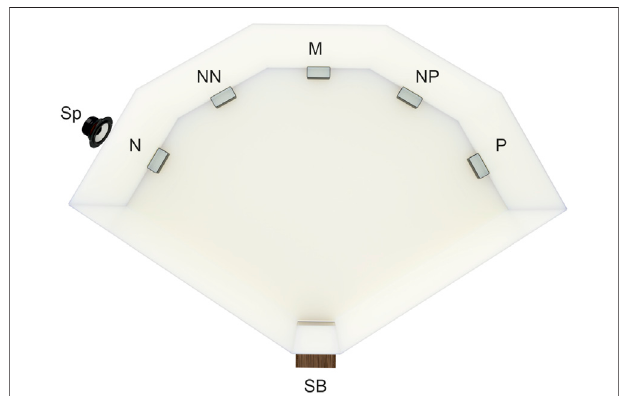
FIGURE1| Theexperimental training/testingarena.Fivepossiblefeeder locations — positive (P, rewarded by the mealworms), negative (N, punished, empty feeder plus white noise via speaker Sp), and the three ambiguous locations(neitherrewardednorpunished),nearpositive(NP),middle(M), and near negative (NN), start box (SB). For half of the quails, the positive location was on the right side of the test arena (as on the fi gure), and for the other half, it was on the left. During the training and testing, the feeder was placed at only one location per trial.